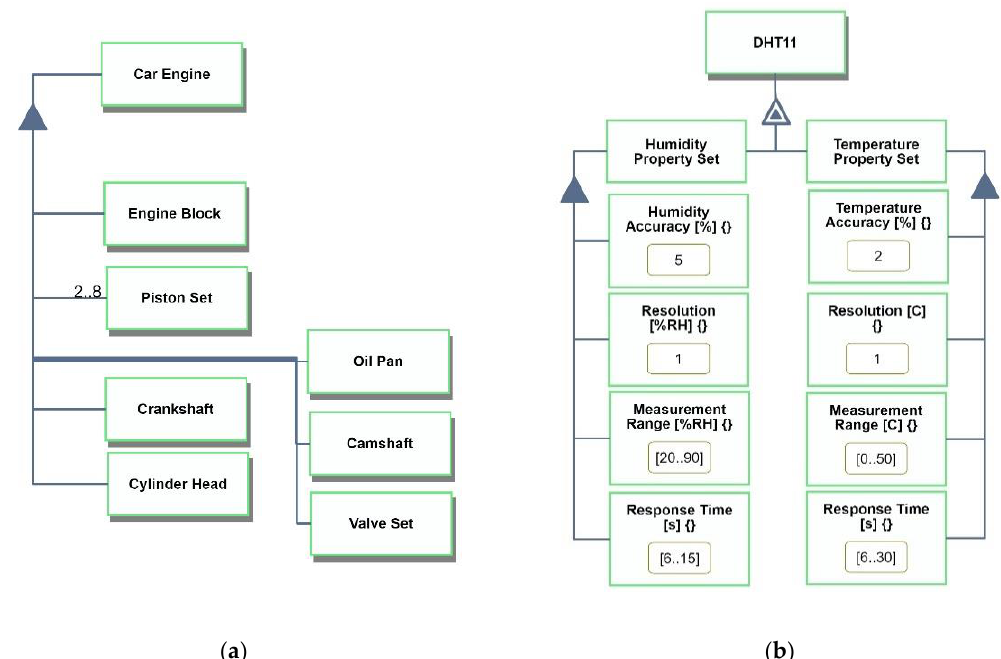
Figure 3. Examples of descriptive ( a ) and prescriptive ( b ) stereotypes.